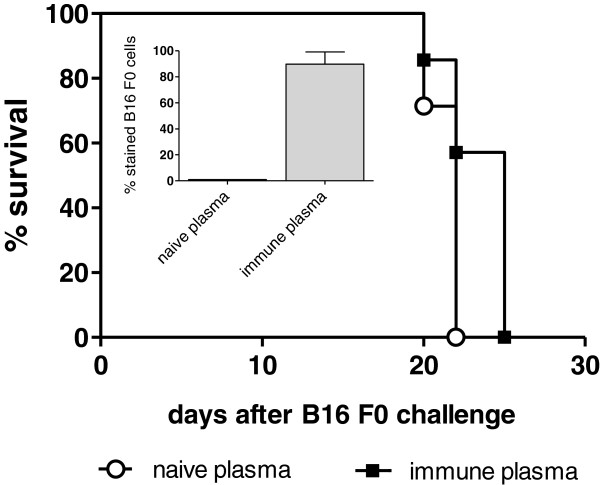
Adoptive transfer of immune plasma. The adoptive transfer of 200 μl of immune plasma simultaneously administered i.p. together with 3 × 103 B16 F0 cells had only a marginal if any effect on tumor growth in comparison to the transfer of naïve plasma: Median survival of mice (n = 7) was 25 versus 22 days (log-rank test, p = 0.044). The inlet figure demonstrates that 90% of B16 F0 cells were stained positive by the mouse immune plasma. The experiment was once repeated with similar results.